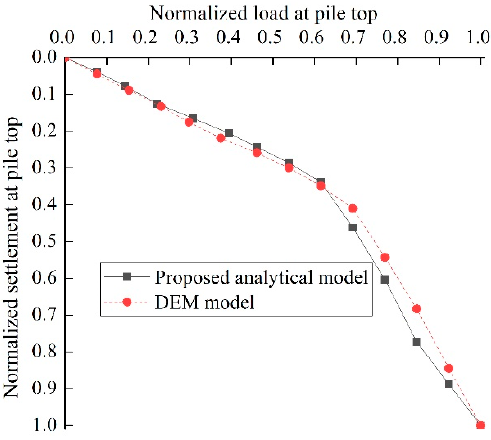
Figure 18. The load at pile top versus the settlement from the analytical method and DEM model.